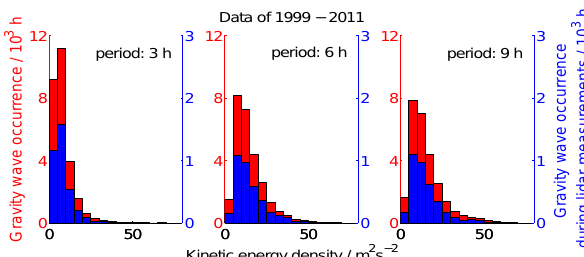
Fig. 10. Gravity wave occurrence of the 3h, 6h and 9h wave in different energy bins. Red: complete summer season dataset of the years 1999–2011. Blue: dataset limited to times of lidar measure-